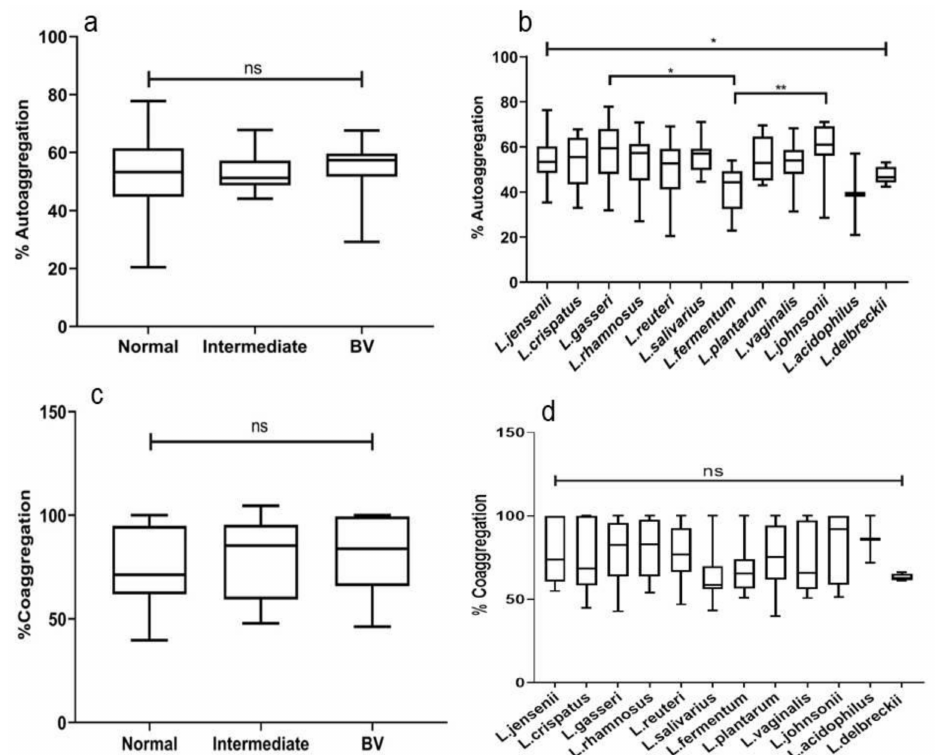
Figure 6. Autoaggregation of ( a ) Lactobacillus isolates from di ff erent groups and ( b ) species-specific % autoaggregation. Candida coaggregation of ( c ) Lactobacillus from di ff erent microbiota and ( d ) coaggregation of various species. The topmost line indicates the Kruskal–Wallis test and downward pointing lines indicate Dunn’s multiple comparison test. Data are represented as a box plot wherein the box indicates the interquartile ranges, line within the bars represents the median and whiskers represent the minimum and the maximum values. ns = not significant, * p < 0.05, ** p <